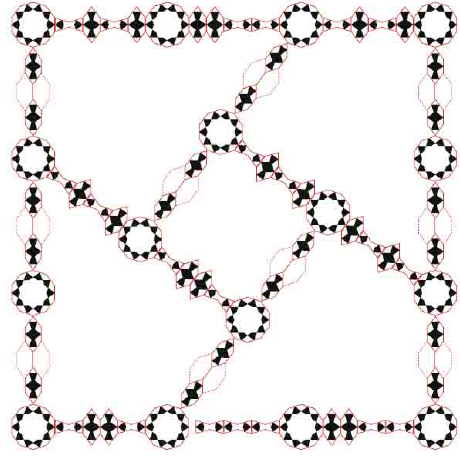
Figure 2: Example of new design subdivisions in girih [16].